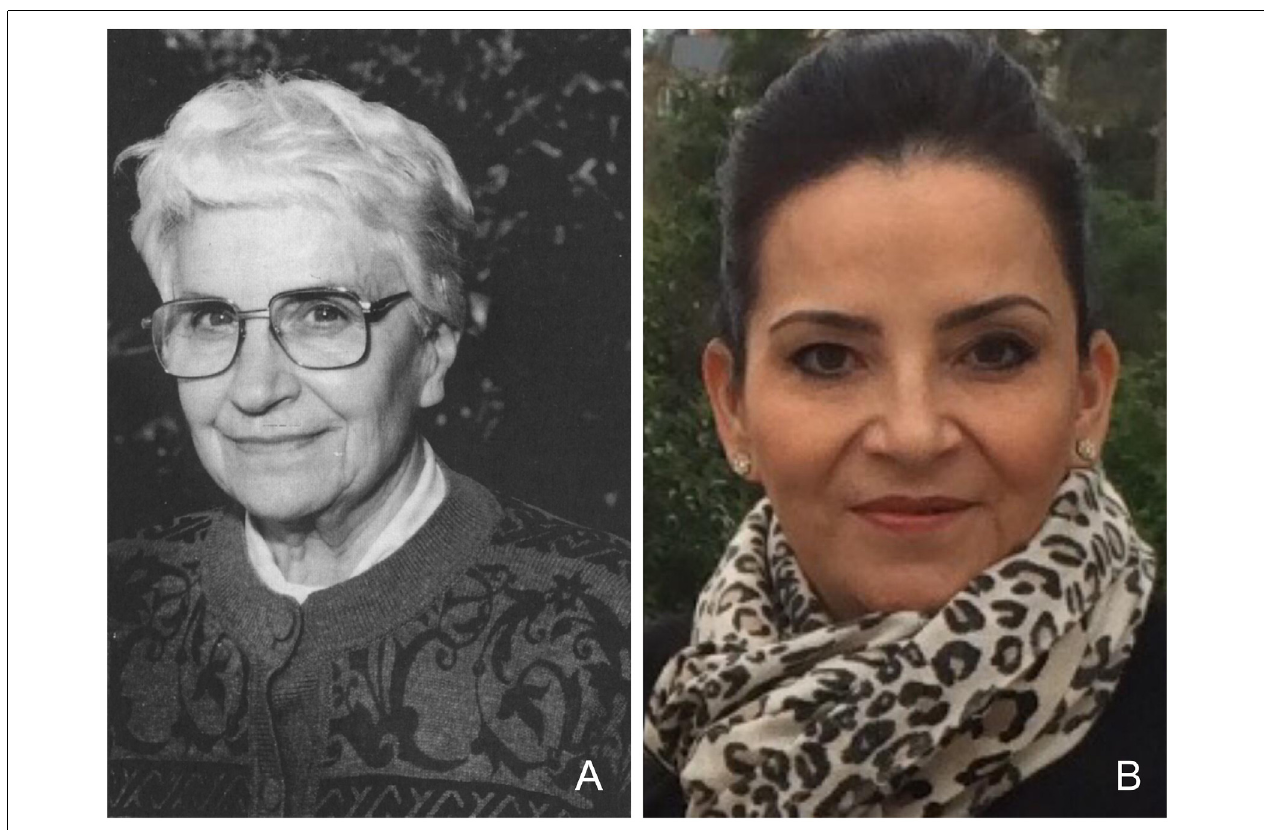
FIGURE 12 | (A) Denise Albe-Fessard, reproduced from Hariz et al. (2014). (B) Ana Luisa Velasco, provided by Ana Luisa